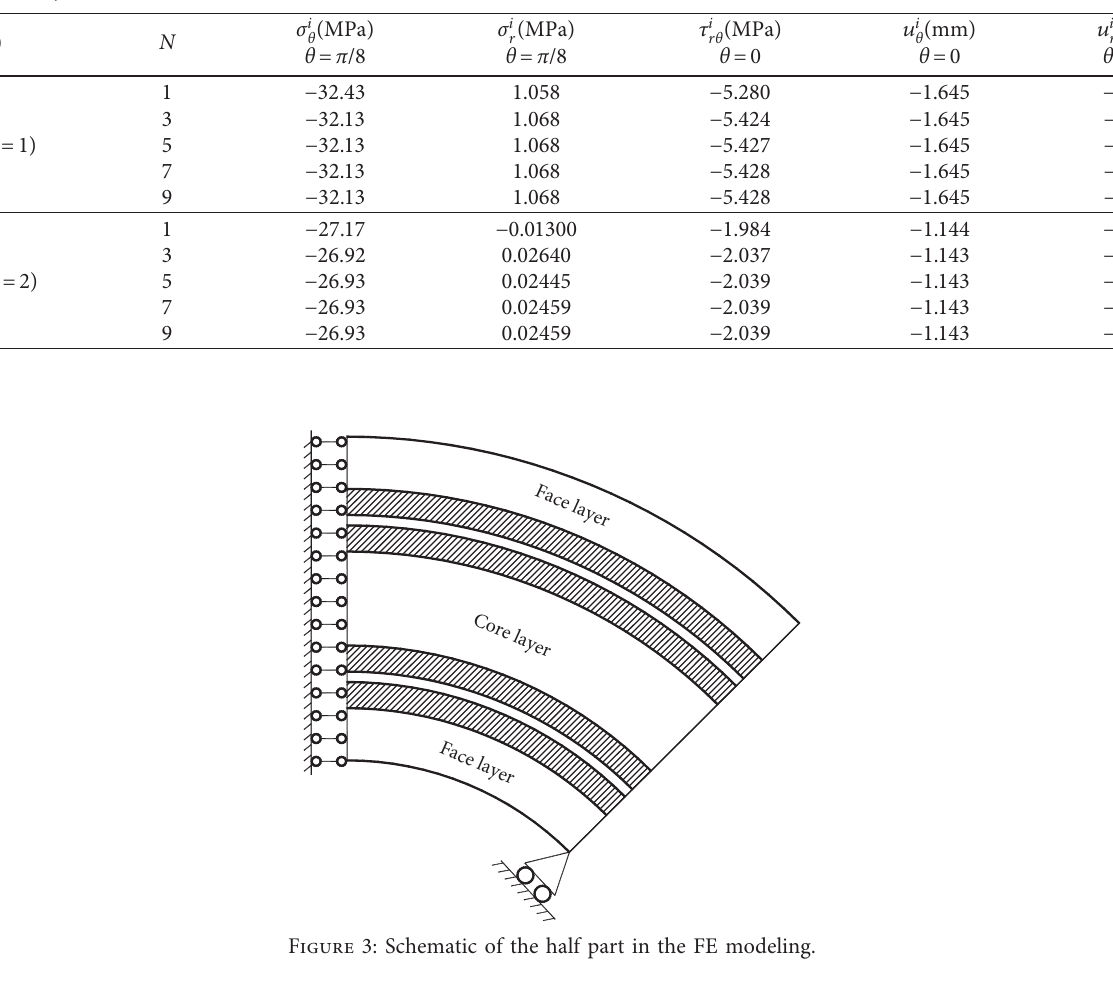
Table 3: The convergence property of the present solution in the face layer ( i � 1) and permeation layer ( i � 2) with different series number N , respectively.